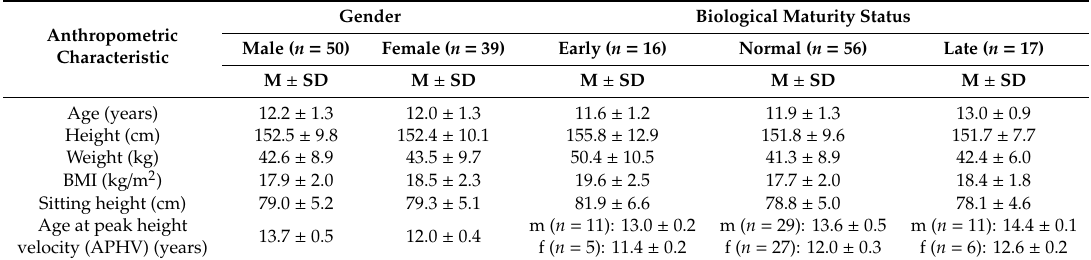
Table 1. Anthropometric characteristics of male and female athletes as well as separated by biological maturity